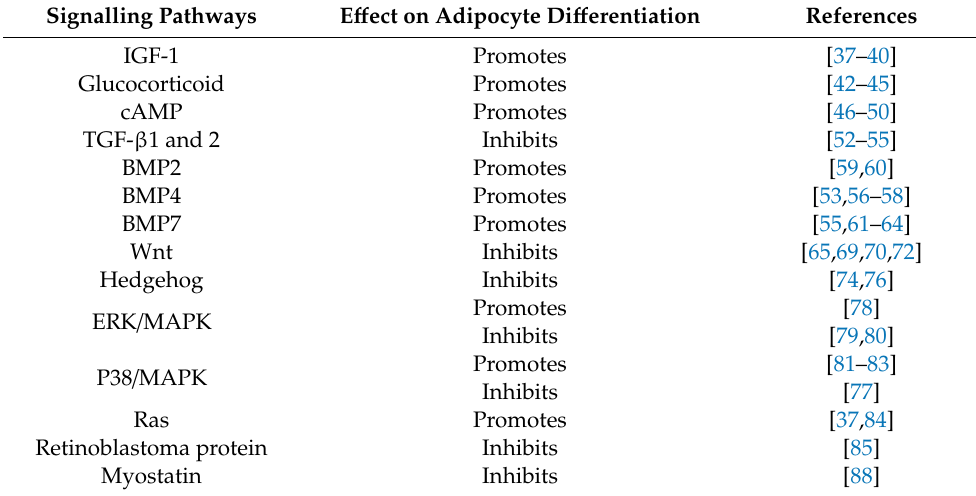
Table 1. Signalling pathways involved in the regulation of